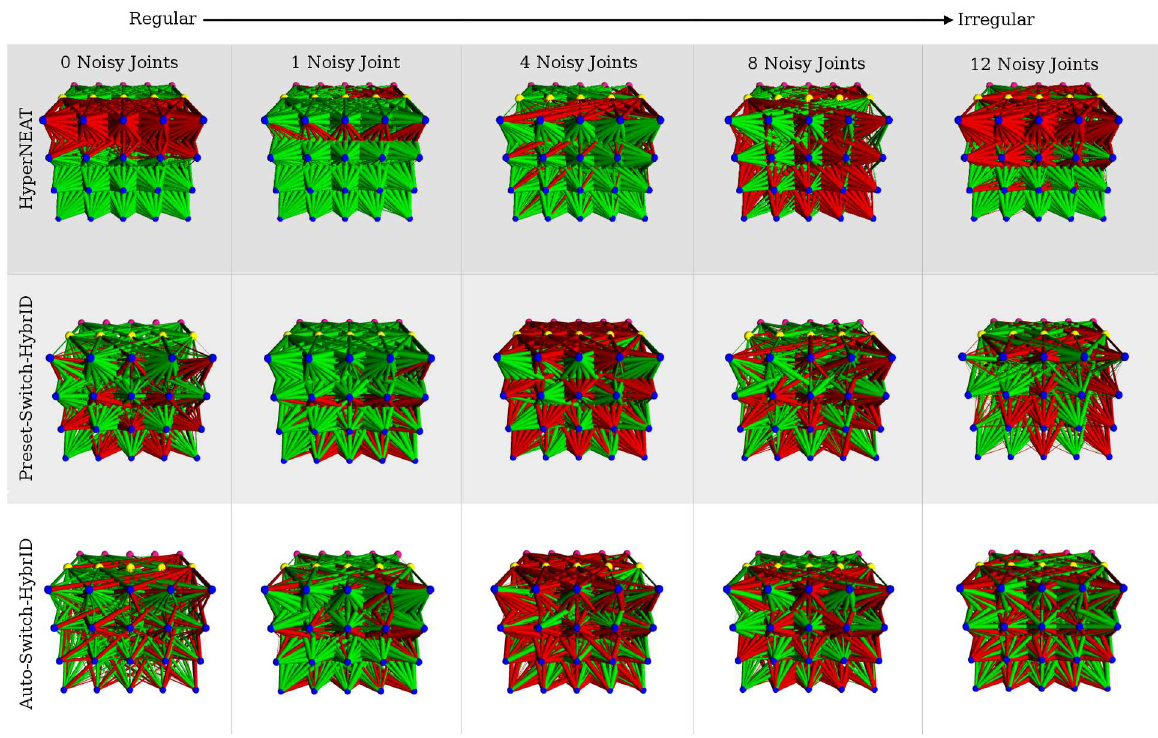
Fig 20. The fittest HyperNEAT, Auto-Switch-HybrID, and Preset-Switch-HybrID ANNs from each regularity of the quadruped robot experiment viewed from the output layer. Red links are inhibitory, green links are excitatory, and link weight magnitudeis indicatedby the thickness of the